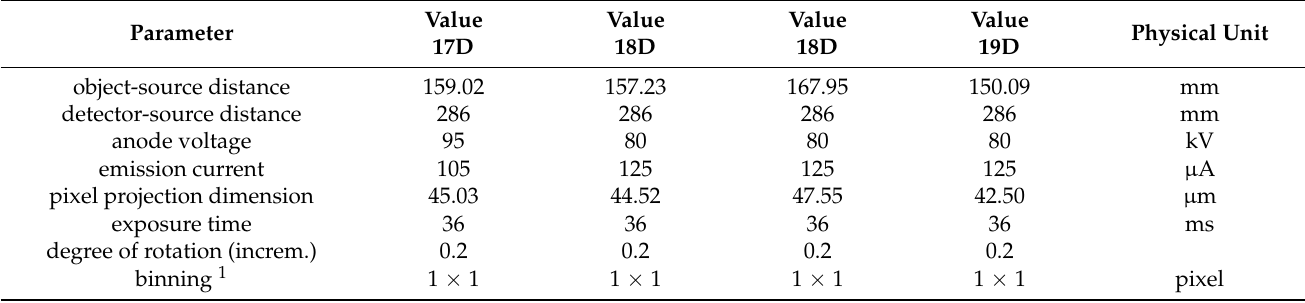
Table A15. Values of set parameters on SkyScan 1275.